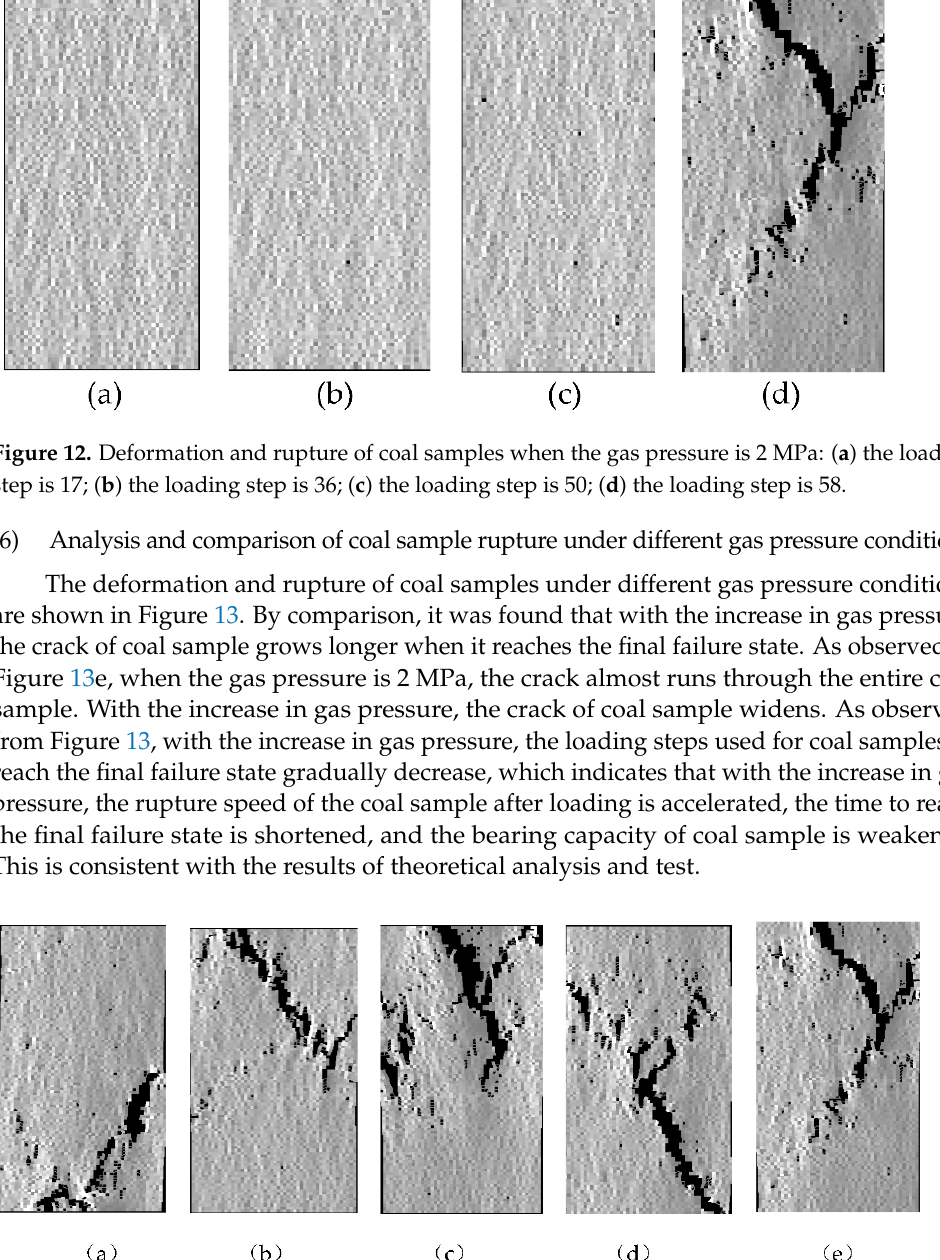
shown in Figure 12. When the loading step is 36, the failure points number a few, the